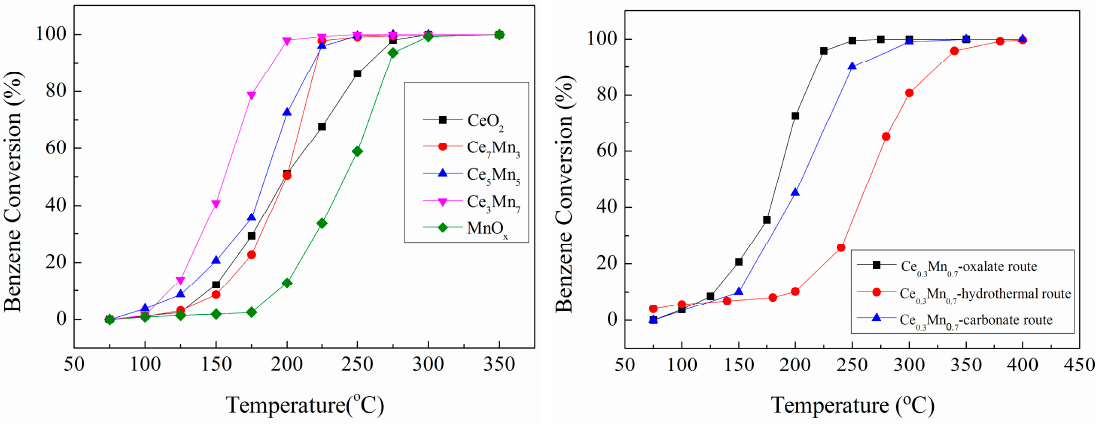
Figure 1. C 6 H 6 conversion (%, ( a )) over CeO 2 , MnO x and Ce x Mn 1 − x catalysts synthesized by oxalate method; C 6 H 6 conversion comparison as a function of reaction temperature over Ce 3 Mn 7 through different reaction route ( b ).